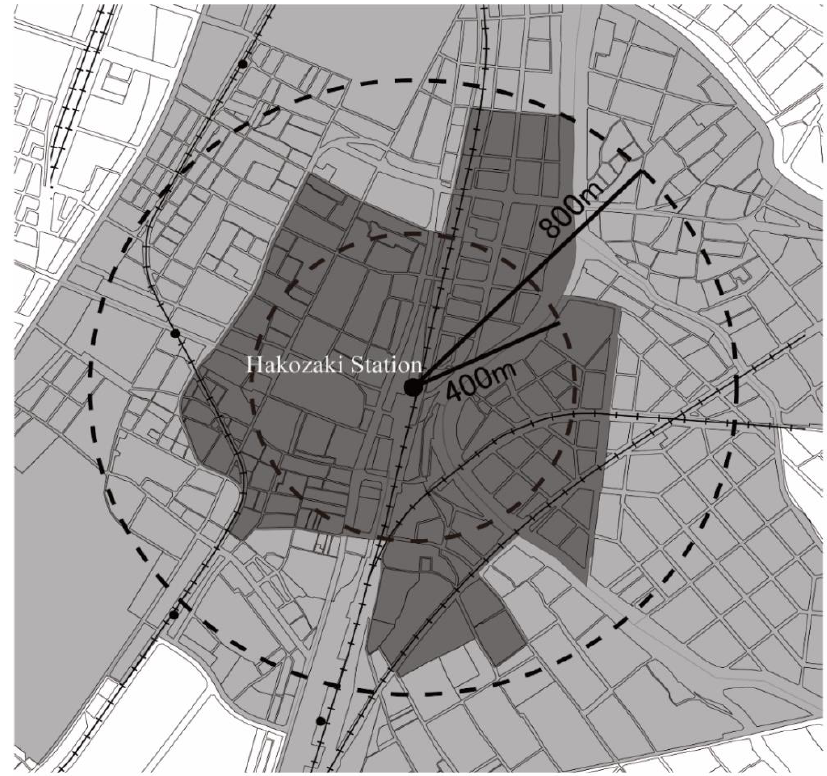
Figure 3. Setting of influence radius of station zones.